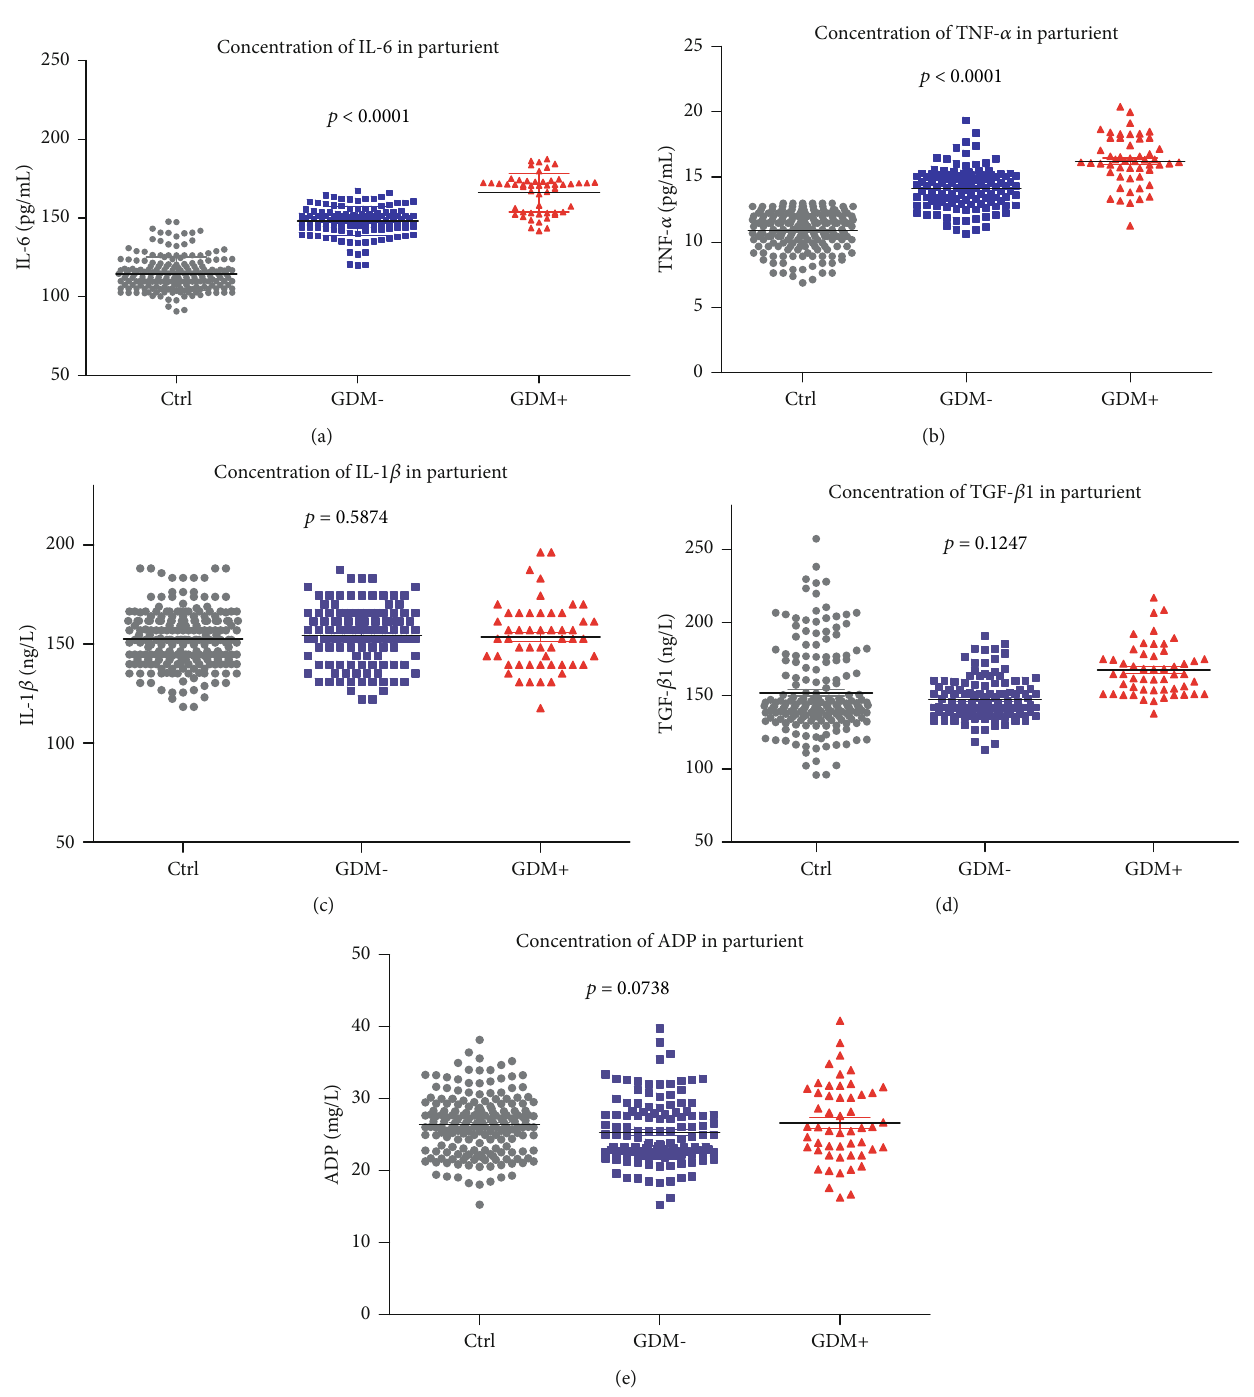
Figure 3: The level of glucose in fl uenced the in fl ammatory cytokines TNF- α , IL-1 β , IL-6, TGF- β 1, and ADP in pregnant women. (a, b) The expression of IL-6/TNF- α was increased among the control, GDM-, and GDM+ groups in pregnant women. (c – e) The expression of IL-1 β , TGF- β 1, and ADP showed no di ff erences among the control, GDM-, and GDM+ groups in pregnant